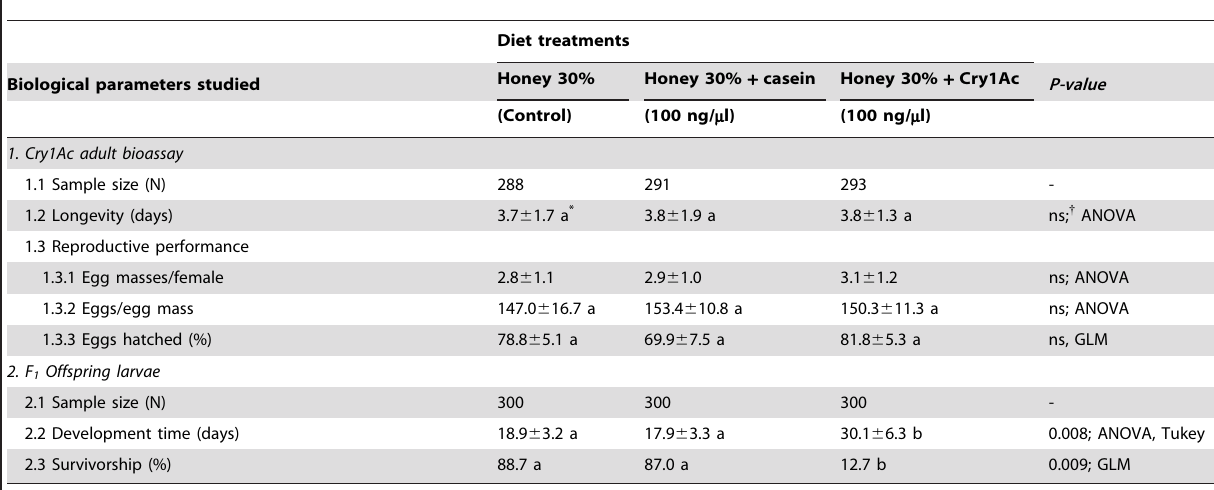
Table 1. Adult diet bioassay with Cry1Ac on adult Chlosyne lacinia and their offspring.